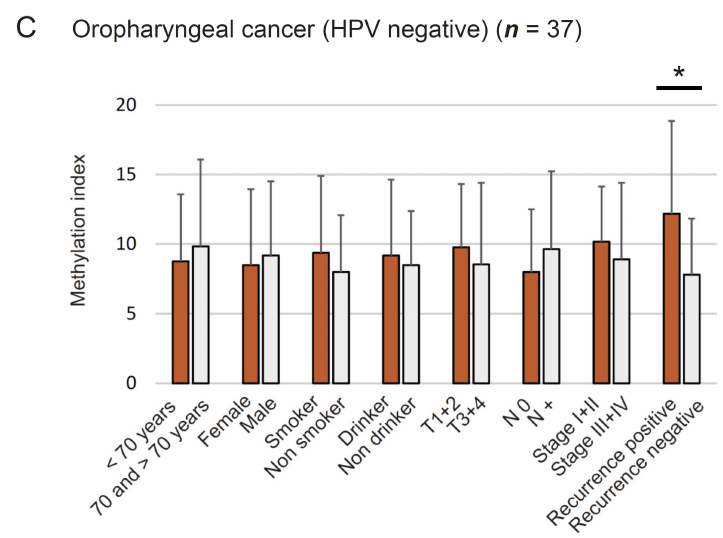
Figure 2. Association between methylation index and selected clinical parameters. The mean methylation index values for various groups have been compared using the Student’s t-test to detect any association between methylation index and selected epidemiologic and clinical characteristics: ( A ) Eighty-five full panel cases. No di ff erences have been noted with respect to clinical characteristics, ( B ) HPV-associated OPC, ( C ) HPV-negative OPC. Mean and standard deviation (SD) have been also indicated, and statistical comparisons between groups are depicted. * p < 0.05 indicates the statistical